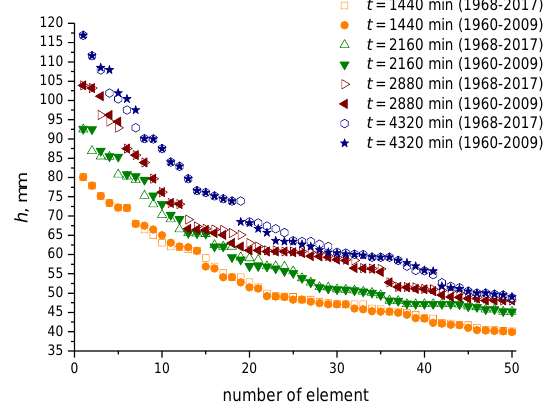
Fig. 4. Comparison of 1440, 2160, 2880 and 4320 minutes duration rainfall in the periods 1960–2009 and